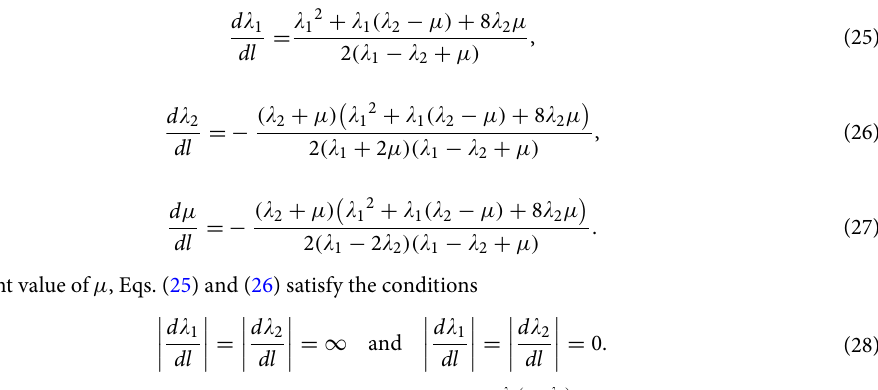
Figure 8. Flow diagram for k pointed by the arrows. The critical and fixed lines are shown as solid and dashed lines